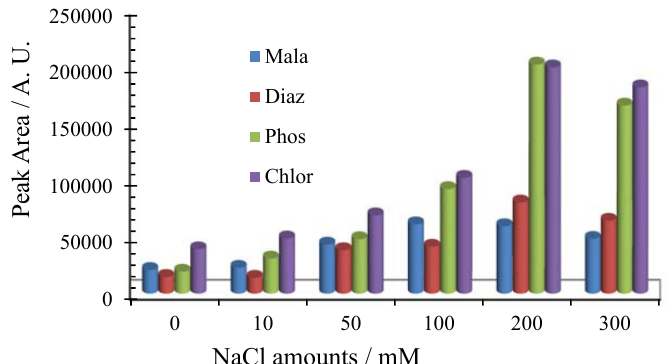
Fig. 5: Effect of ionic strength (NaCl/mM) on the extraction efficiency. Other extraction conditions were as in Fig.